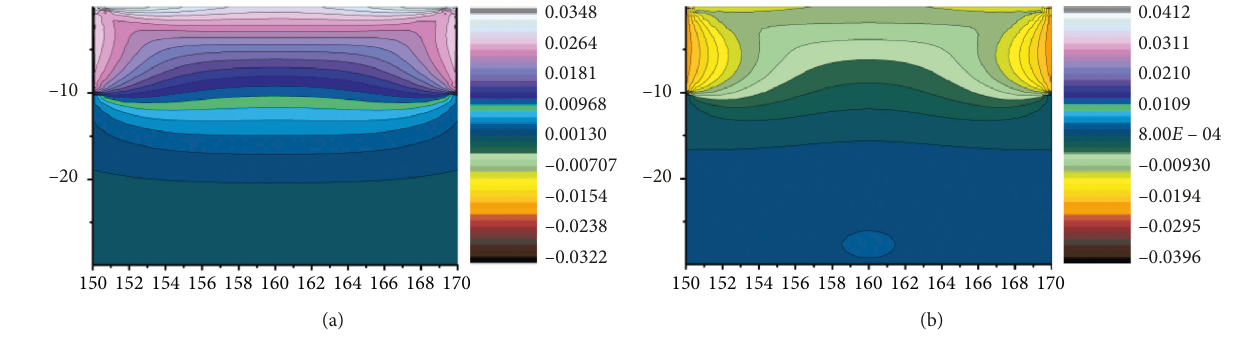
Figure 15: Contour map of ε xx and ε zz in the Ge mesa area.